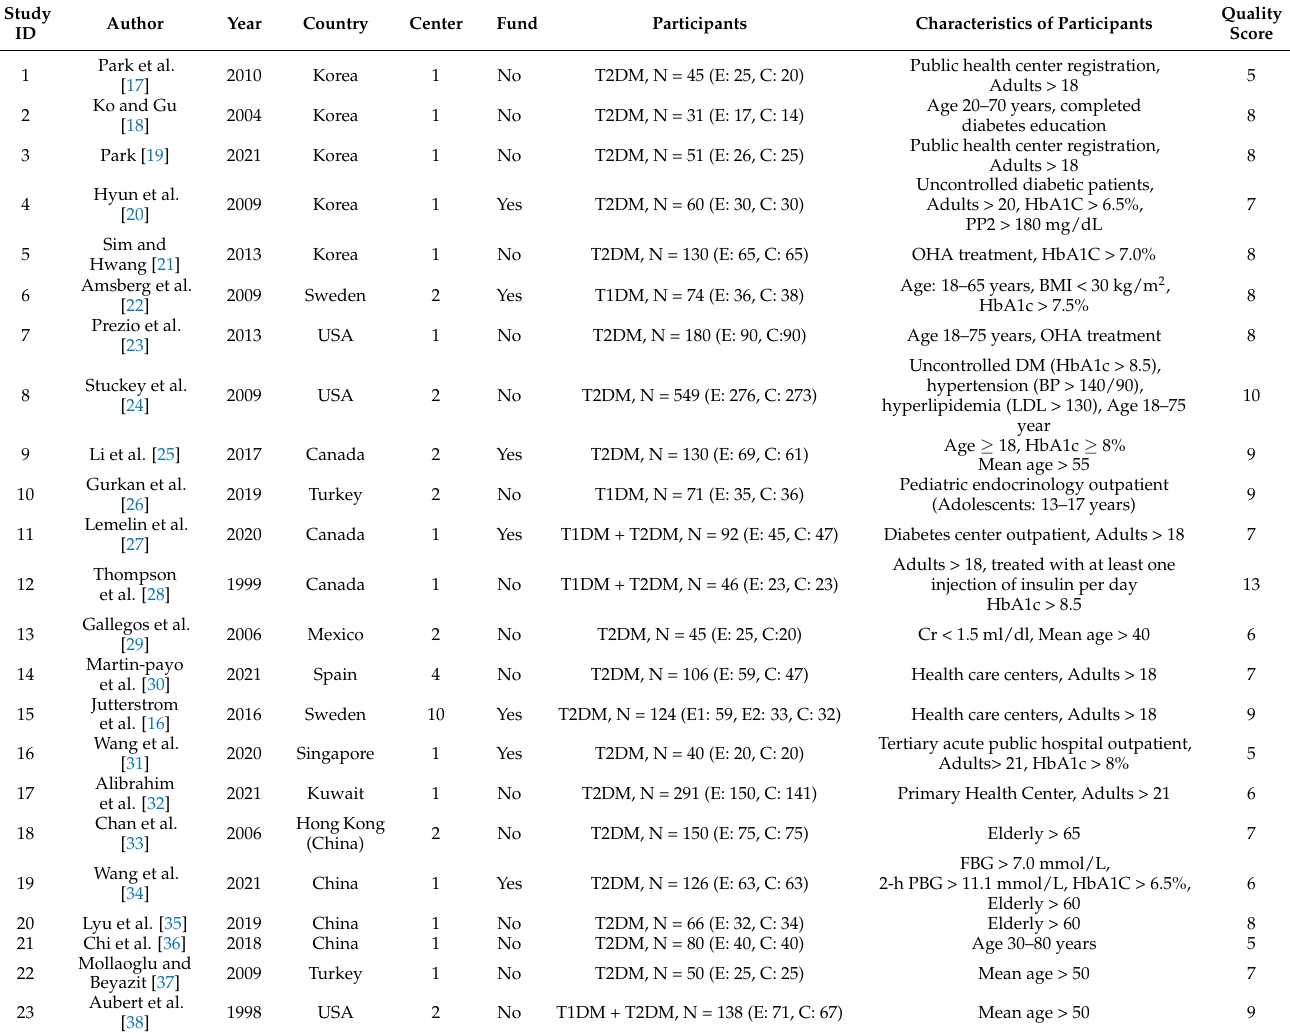
Table 1. Characteristics of the included